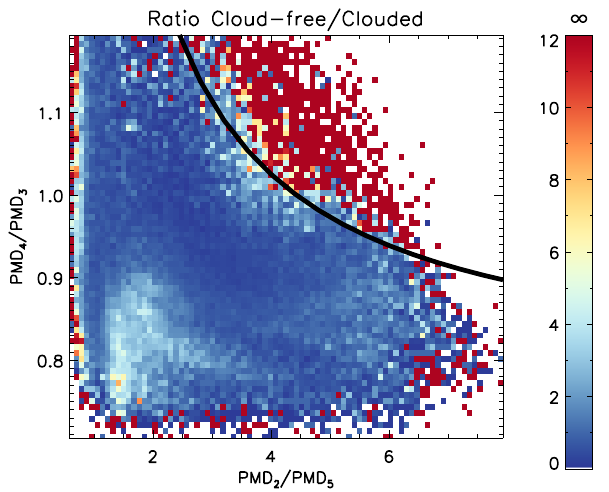
Fig. 1. Density plot showing the ratio of the number of cloud-free and clouded observations (according to MODIS) as a function of the SCIAMACHY ratios PMD 4/PMD 3 and PMD 2/PMD 5. Note that dark red indicates no cloudy measurements were present for those particular ratios, while white at the edges of the image indicates no measurements were present at all. The black curve indicates the cloud-free optimised boundary between the cloud-free and clouded regions.